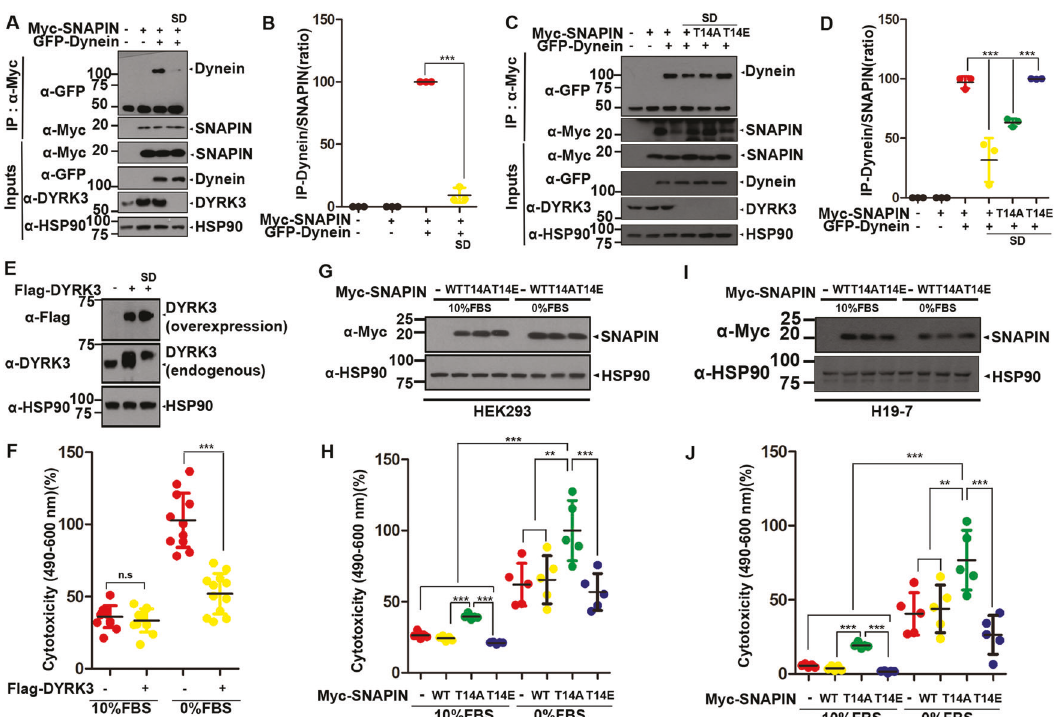
Fig. 6 Blockade of SNAPIN phosphorylation via the reduction of DYRK3 contributes to cell toxicity under serum deprivation. A After HEK293 cells were transfected for 24 h with a plasmid encoding Myc-SNAPIN or GFP-Dynein alone or in combination, the cells were left untreated or treated for additional 6 h with DMEM. Cell lysates were immunoprecipitated with anti-Myc antibody, followed by immunoblotting with the indicated antibody . B Quanti fi cation of the blots in (A). All data represent the mean ± standard deviation of three independent experiments (*** p < 0.001). C HEK293 cells were transfected for 24 h with a plasmid encoding Myc-SNAPIN, Myc-SNAPIN- T14A, Myc-DNAPIN-T14E, or GFP-Dynein alone or in combination, and were left untreated or treated for 6 h with DMEM. Cell lysates were immunoprecipitated with anti-Myc antibody, followed by immunoblotting with the indicated GFP antibody. D Quanti fi cation of the blots in C . All data represent the mean ± standard deviation of three independent experiments (*** p < 0.001). E HEK293 cells were mock-transfected (-) or transfected for 24 h with a plasmid encoding Flag-DYRK3 alone, and cells were immunoblotted using anti-Flag or anti- DYRK3 antibody. Hsp90 served as a loading control. G , I After HEK293 G or H19-7 cells I were transfected for 24 h with a plasmid encoding Myc-SNAPIN, Myc- SNAPIN-T14A, or Myc-SNAPIN-T14E, the cells were left untreated or treated for an additional 6 h with DMEM. Cells were immunoblotted using the indicated antibody. F, H, J Where speci fi ed, the cytotoxicity from the samples in E , G , and I was measured by the amount of LDH released into the cultured media, respectively. The graph represents the mean ± standard deviation of twelve-independent experiments (** p < 0.01, *** p < 0.001, n.s., not signi fi affects the gene expression of DYRK3 . Consistent with our data, the stability of various mRNA transcripts, including poly(A)-speci fi c ribonuclease, in mammalian cell lines was previously reported to be reduced under serum deprivation conditions [34]. Taken